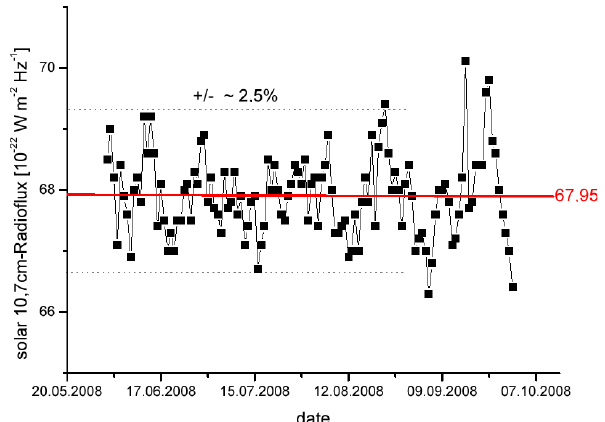
Fig. 1. Shown are very small variations of the solar 10.7cm ra- dioflux (daily measured from NGDC, Ottawa, Canada) from June to August 2008 with an average value of ≈ 67.95 ± 2.5% indicating a stable averaged solar Ly- α -radiation input.